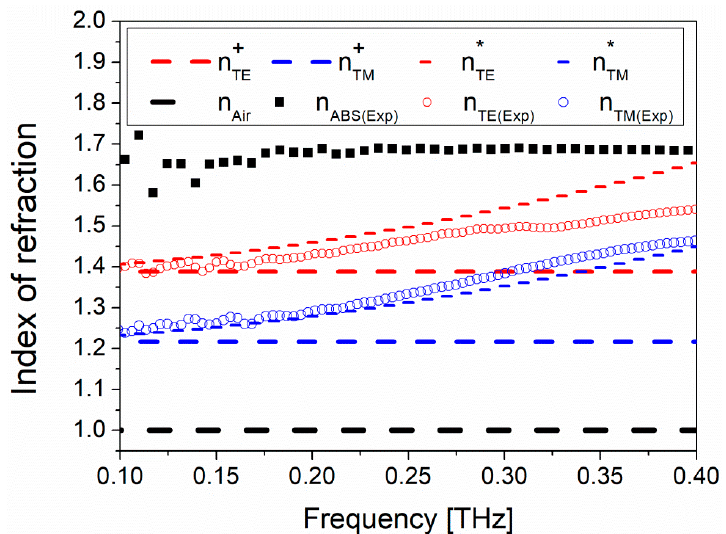
Figure 2. Comparison of the index of refraction calculated from the static case solution ( 𝑛 (cid:3021)(cid:3006)(cid:2878) and 𝑛 (cid:3021)(cid:3014)(cid:2878) , long-dashed curves), the 2nd-order EMT solution ( 𝑛 (cid:3021)(cid:3006)∗ and 𝑛 (cid:3021)(cid:3014)∗ , short-dashed curves) and experimentally measured values (open circles), as a function of frequency. The experimentally measured index of refraction for the ABS is also shown using black squares.